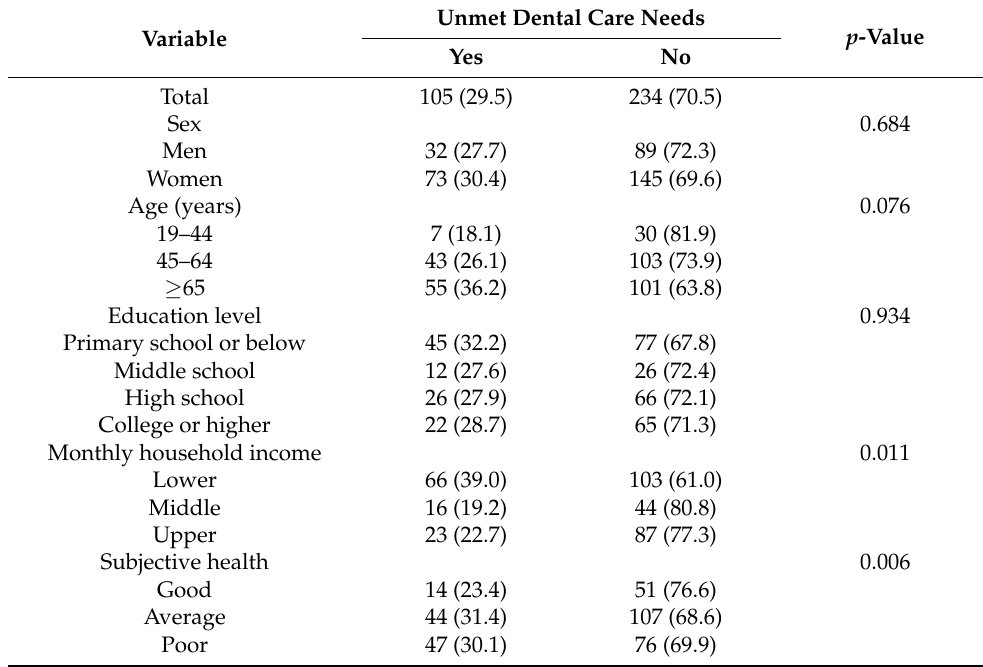
Table 1. Unmet dental care needs according to the general characteristics of cancer